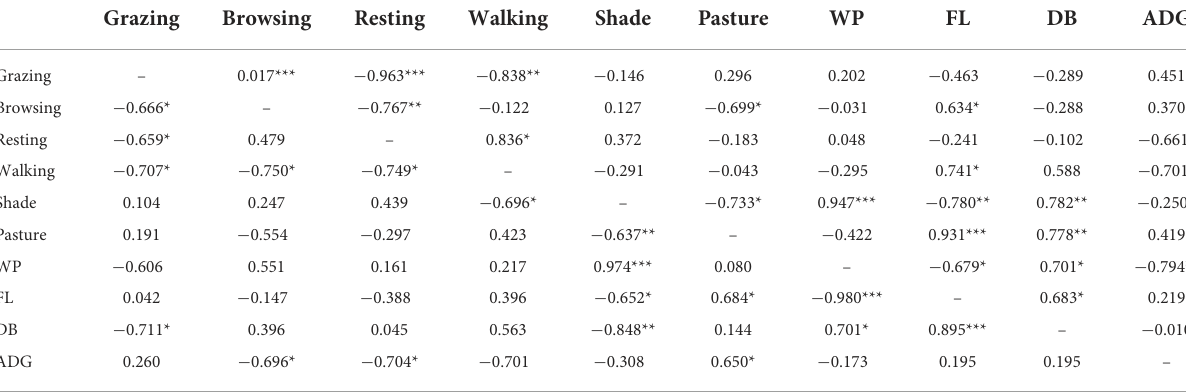
TABLE 4 Correlation values among the tested variables of interest for the Boran (top) and Nguni (bottom) diagonal. Grazing Browsing Resting Walking Shade Pasture WP FL DB ADG Grazing 0.017***